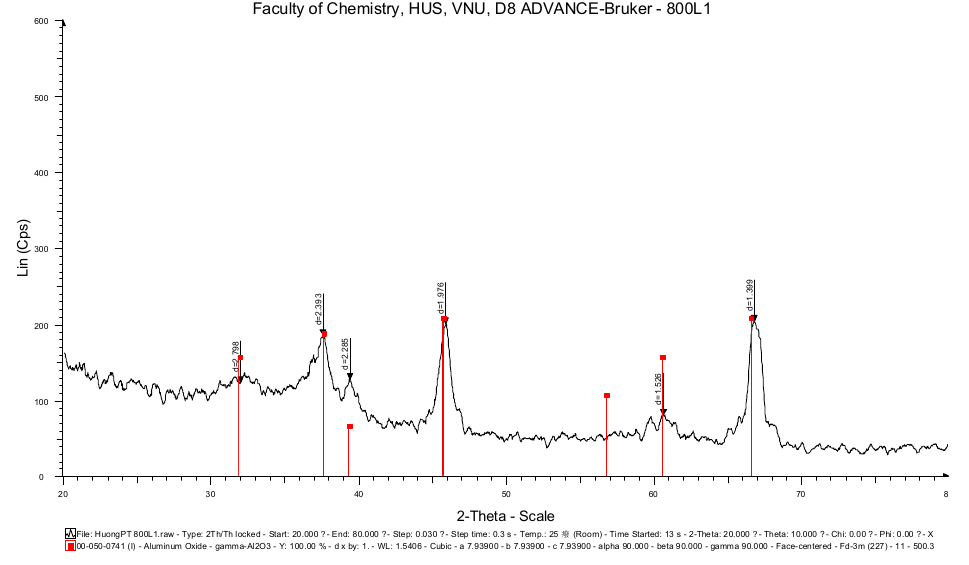
Figure 2. XRD pattern of synthesized γ -Al 2 O 3 nanoparticles.